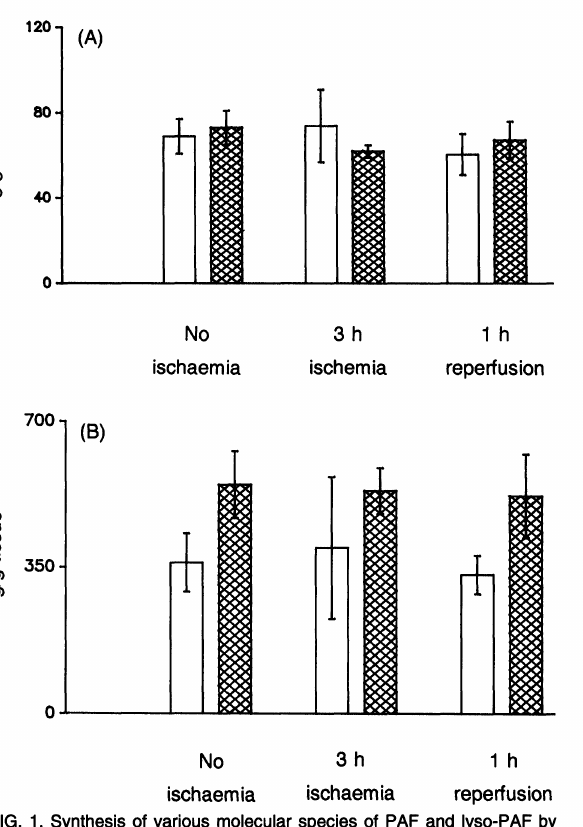
FIG. 1. Synthesis of various molecular species of PAF and lyso-PAF by intestinal mucosal tissue before ischaemia, after 3 h ischaemia, and after h reperfusion. All analytes were measured by stable isotope dilution GC/ MS as described in Methods. All results are mean + S.E.M., n 8. Note the dramatic differences in the scales of the upper panel (PAF) and the lower panel (lyso-PAF). Panel (A): rl, 16:0 PAF; I, 18:0 PAF. Panel (B): I-’l, 16:0 lyso-PAF; !, 18:0 lyso-PAF.